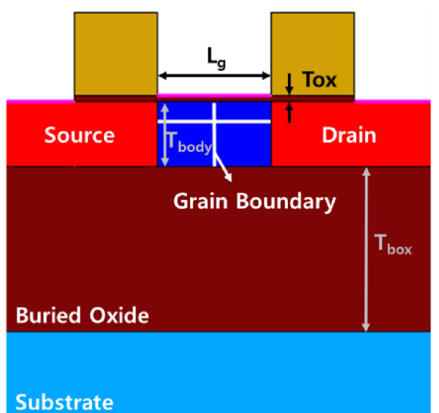
Figure 1. Simulated structure of poly-Si 1T-DRAM cell with a lateral GB and vertical GB.